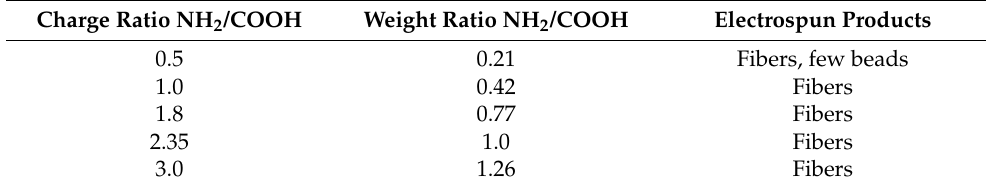
Table 5. Relation between polyelectrolyte complex system (PEC) composition and electrospinning results. Charge Ratio NH 2 /COOH